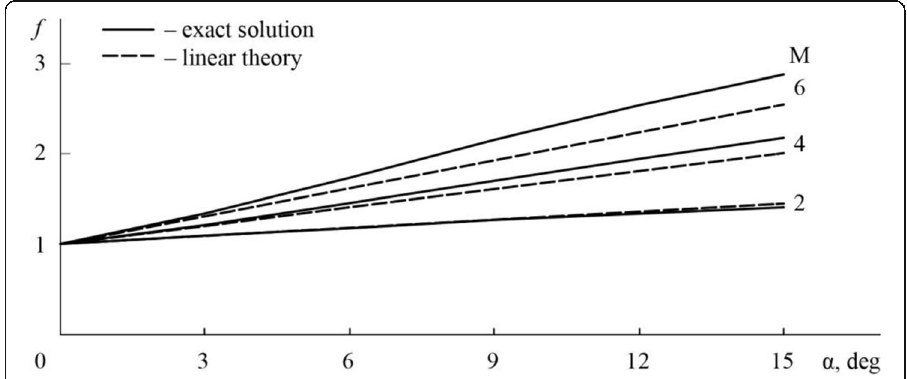
Fig. 2 Mass flow rate for intake under a flat plate: linear theory (dotted lines), and the exact solution (solid